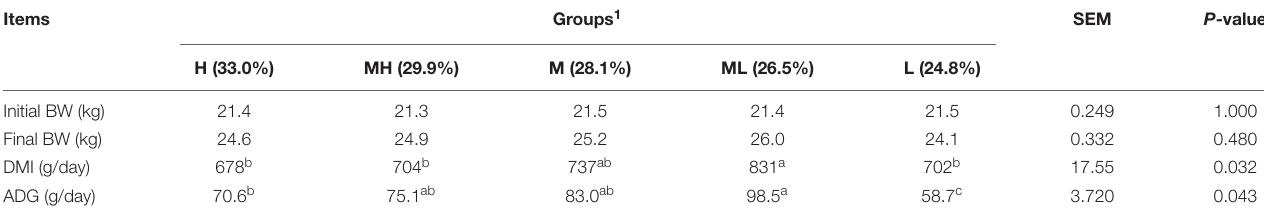
TABLE 2 | Effects of different contents of peNDF 1 . 18 in diets on the BW, ADG, and DMI of goats. Items Groups 1 SEM P -value